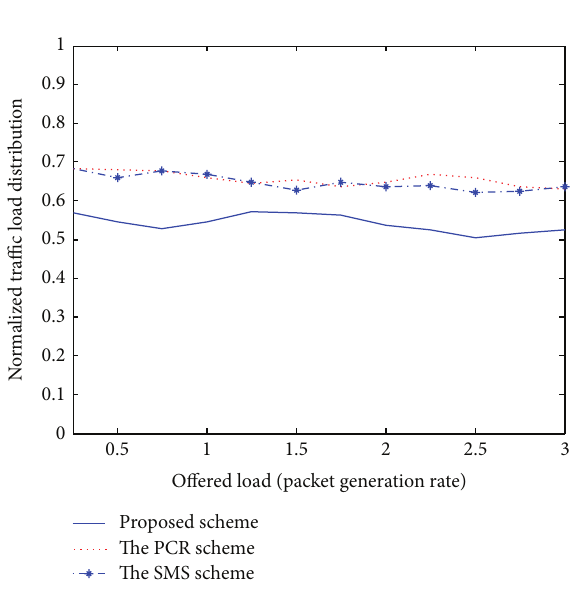
Figure 4: Energy-exhaustion ratio.